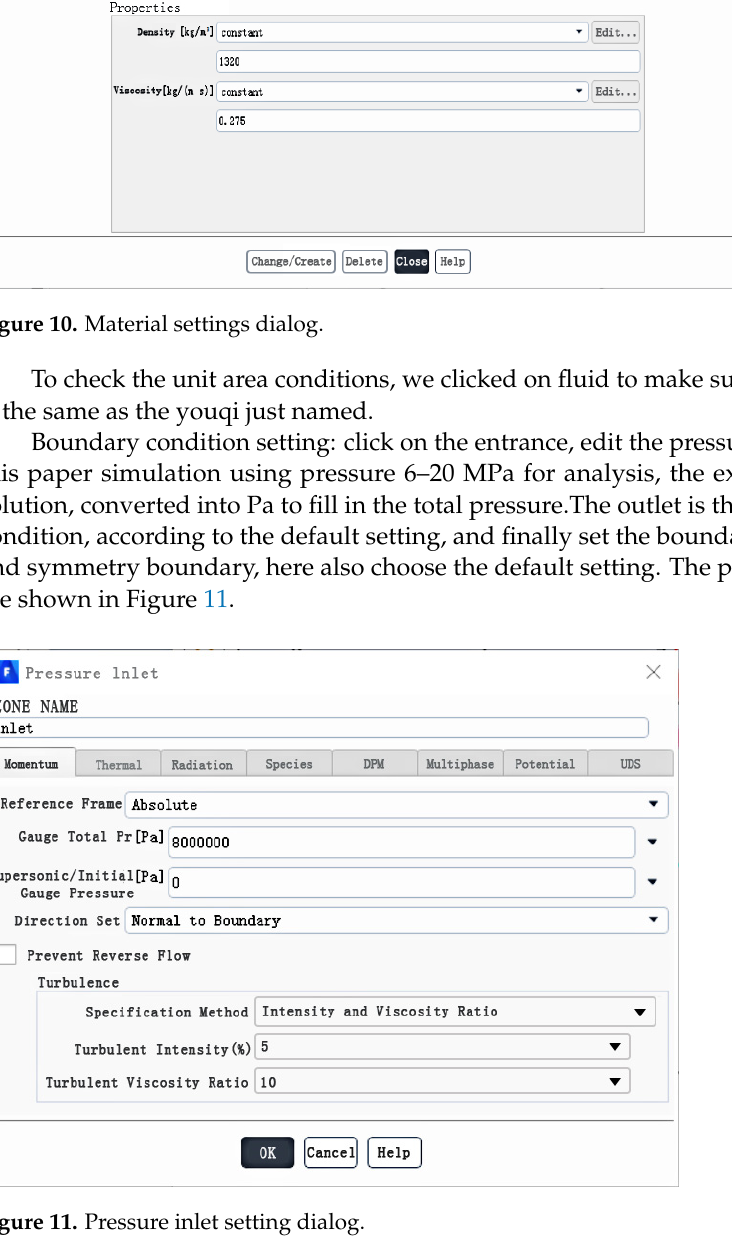
( d ) Figure 12. Shipyard experimental paint and operation: ( a ) Topcoat base (SIGMADUR 550 BASE RAL 3000); ( b ) Hardener (SIGMADUR) 188/520/550; and ( c ) Thinner21-06 (AMERCOAT). ( d ) The worker is mixing three paints in proportion.